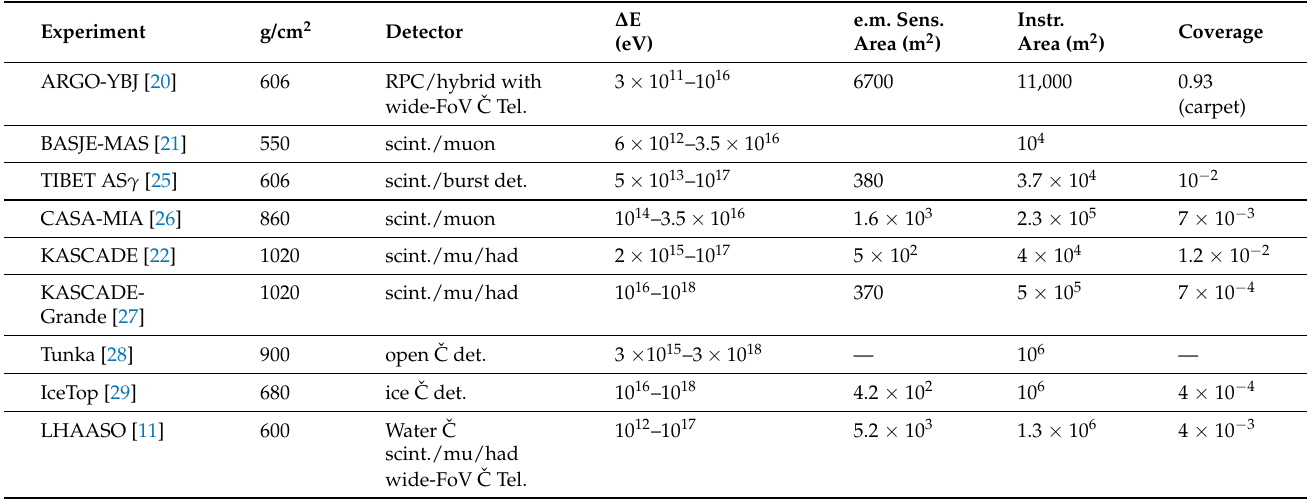
Table 1. Characteristics of different air shower arrays.